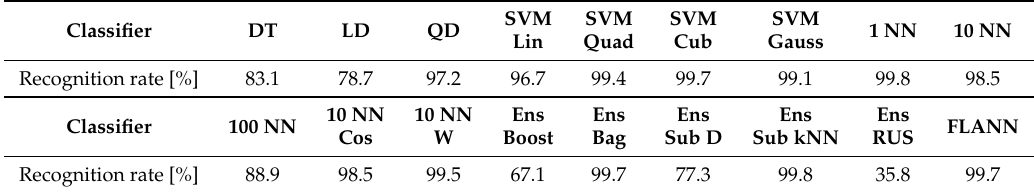
Table 4. 10-fold cross-validation results for dataset 1, configuration (i), variant (b).